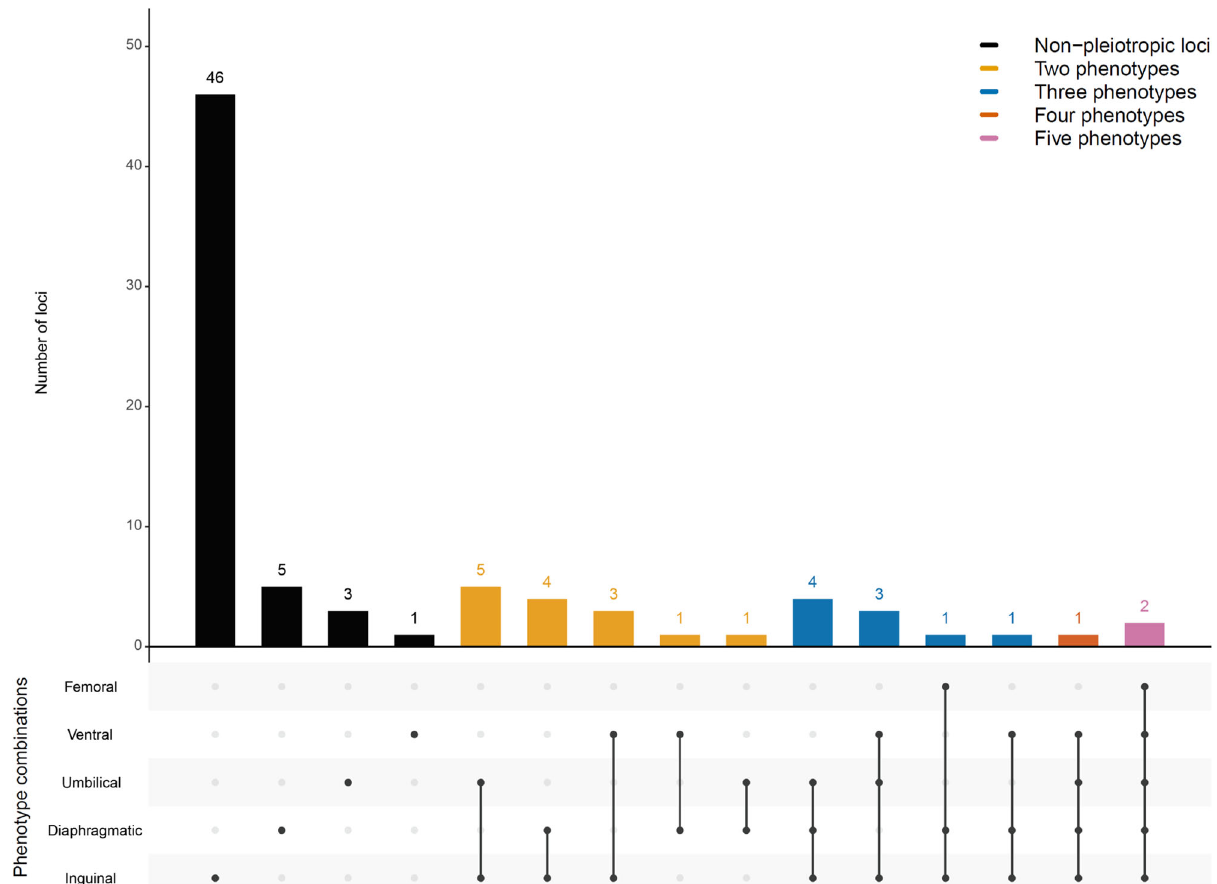
Fig. 3 MultiPhen results for associated loci. Distribution of the associated hernia traits (a trait is considered associated if P < 0.01 in the MultiPhen analysis, adjusting for 5 analyzed phenotypes) for the 81 associated